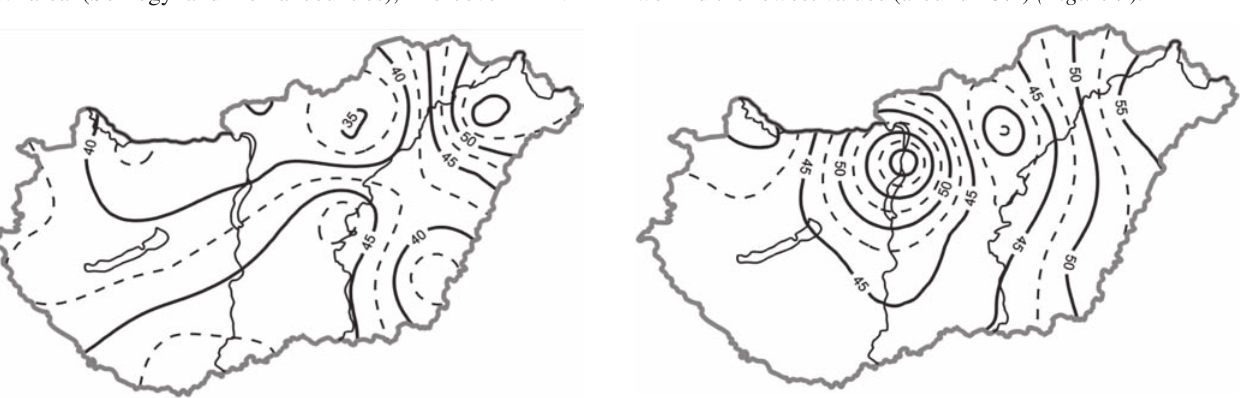
Figure 8 – The mean values of coeffi cients of variation (CV) of the absolute daily maxima of precipitation in autumn measured at 16 stations over a period of 1951–2010